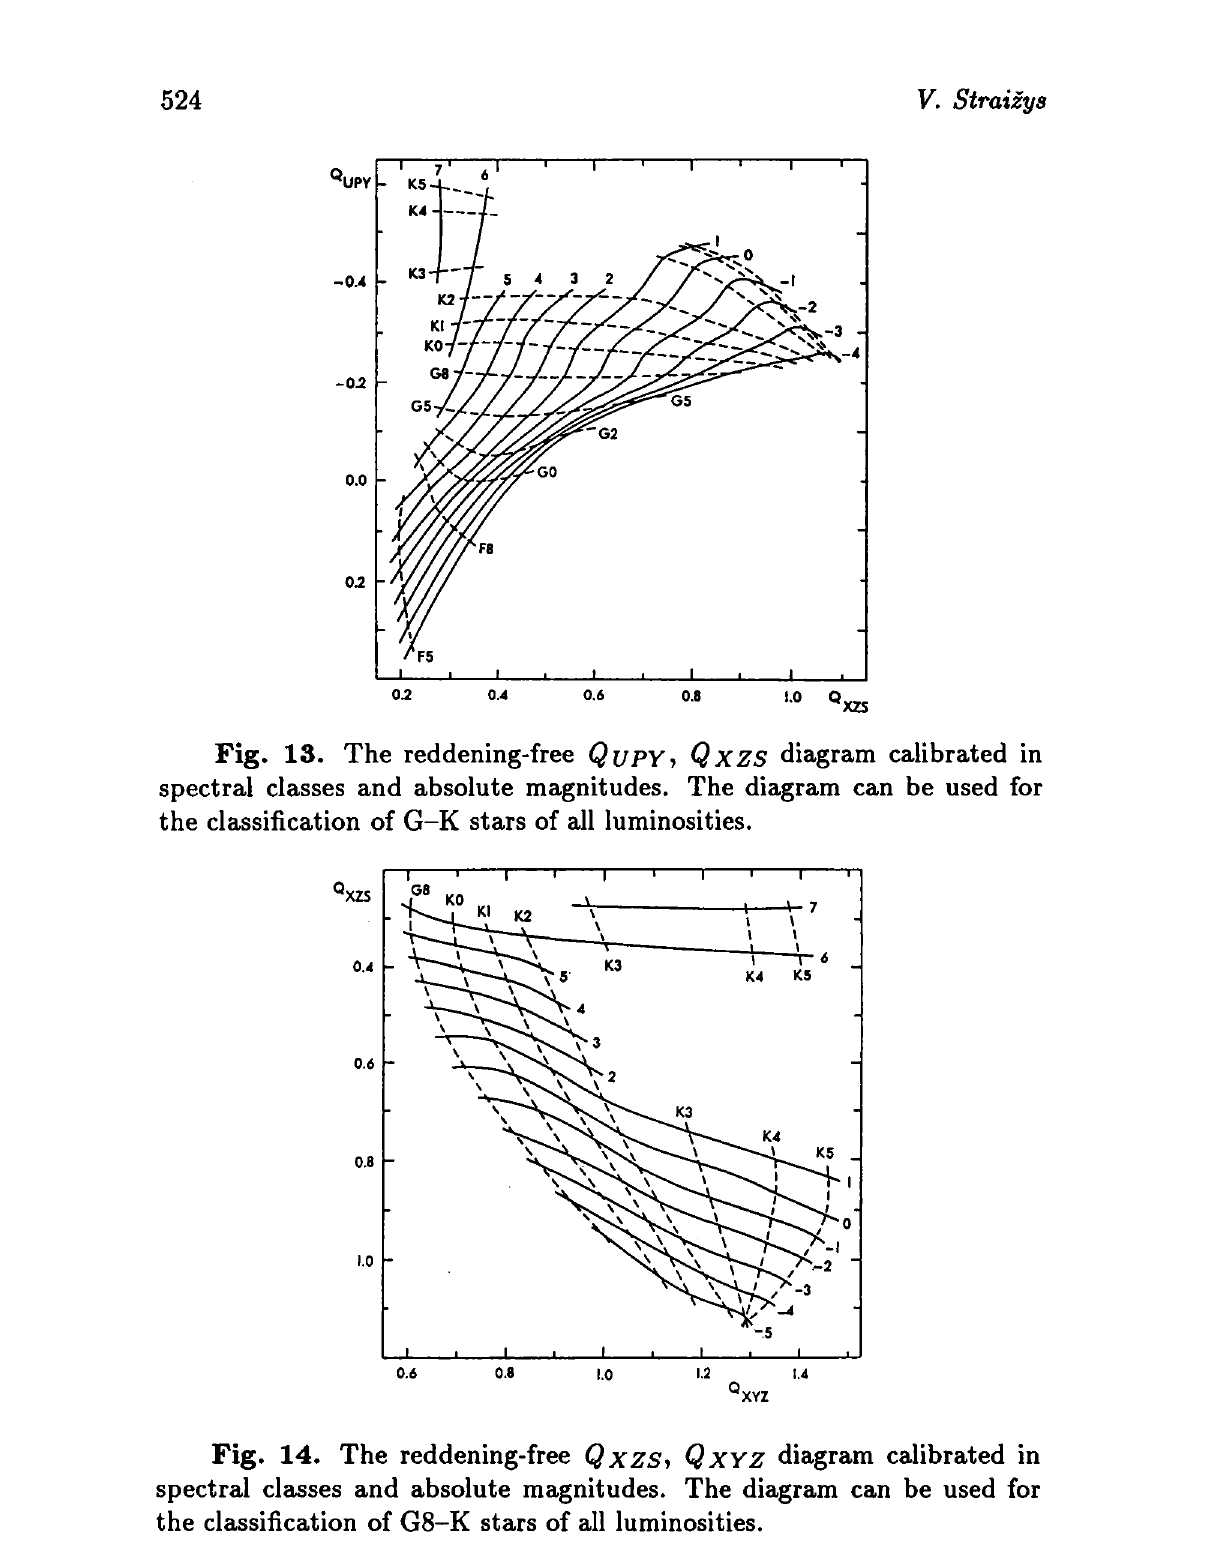
Fig. 14. The reddening-free Qxzs > QxYZ diagram calibrated in spectral classes and absolute magnitudes. The diagram can be used for the classification of G8-K stars of all